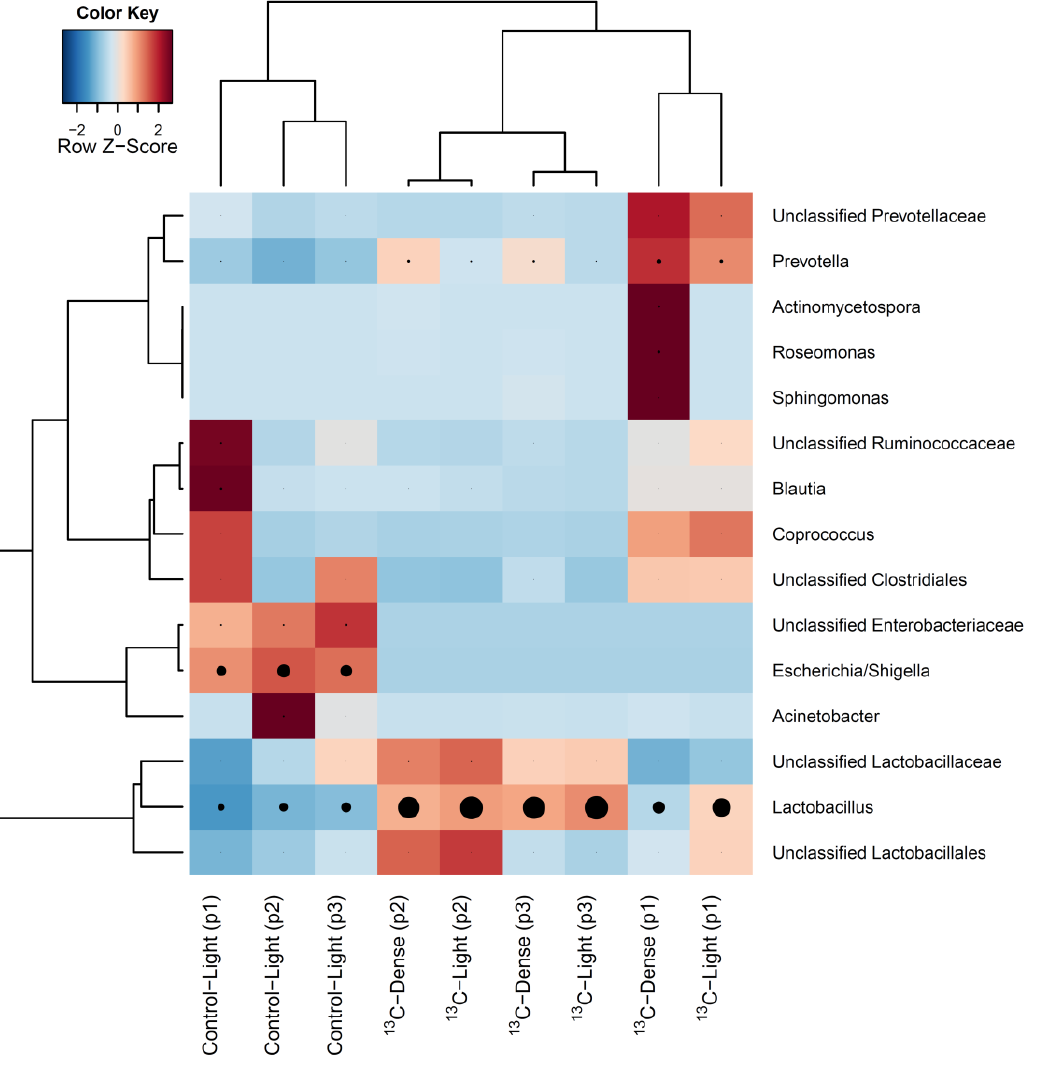
Figure 4. Heatmap showing hierarchical clustering of bacterial composition profiles of the 15 most relatively abundant taxa in cDNA from RNA-SIP density gradient fractions. Taxa are indicated by row labels and gradient fraction type indicated by column labels; ‘light’ fractions from control culture (Control-Light), ‘light’ fractions from 13 C-sialic acid cultures ( 13 C-Light), and ‘dense’ fractions from 13 C-sialic acid cultures ( 13 C-Dense). Identification in parentheses indicates the piglet source. Heatmap colour (blue to dark red) signifies the relative prevalence of each taxon across samples and black circles show absolute proportions for each taxa within a sample, with circle size proportional to sequence